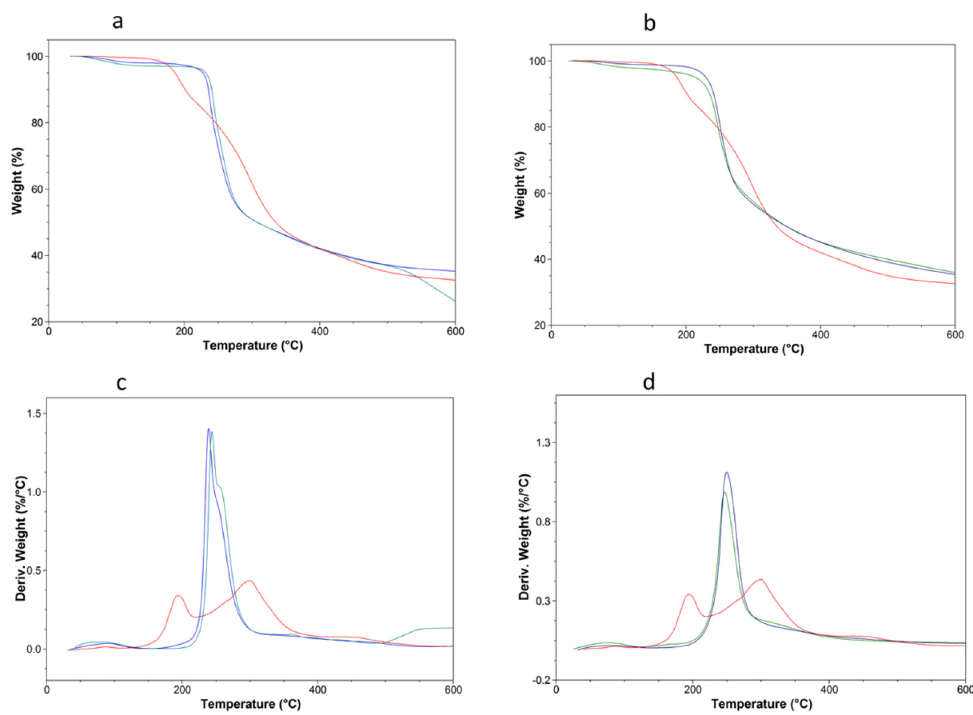
Figure 3. Thermogravimetric curves for ( a ) green MPHA, blue MPHA-OLE, red OLE; ( b ) green MPCs, blue MPCs-OLE, red OLE, and the respective derivative curves ( c ) and ( d ) ( n = 2).